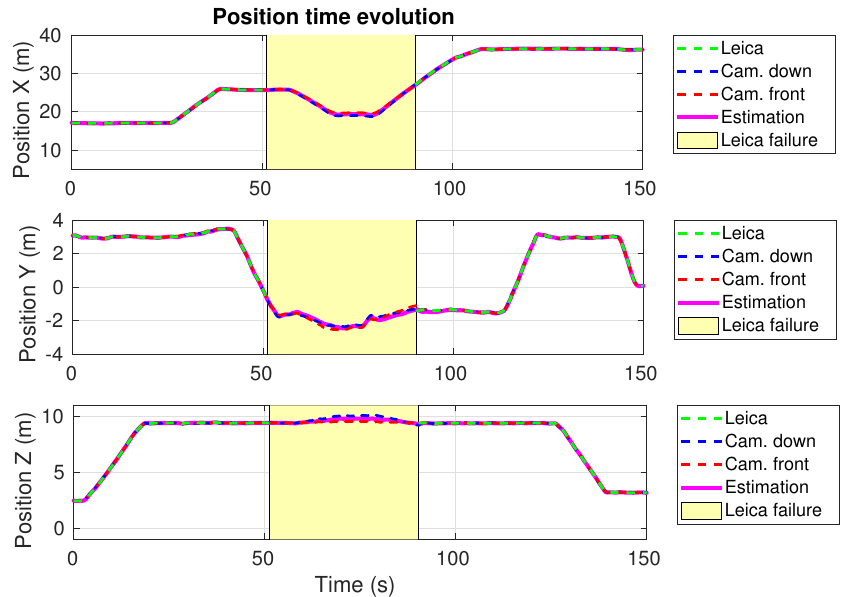
Figure 9. Experiment 2. Time evolution of the estimated X, Y and Z UAV positions provided by our localization system (magenta), the two calibrated camera measurements (blue and red), and the Leica total station (green). The intervals without total station data are shown in